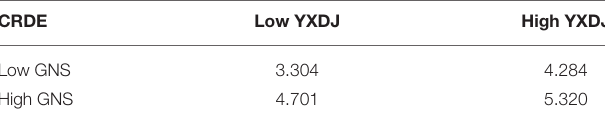
TABLE 15 | The corresponding data of moderating and interaction effect